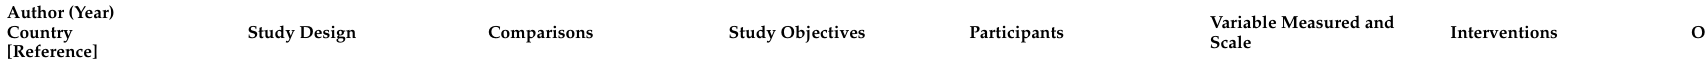
Table 2. Characteristics of the studies included in the systematic review and